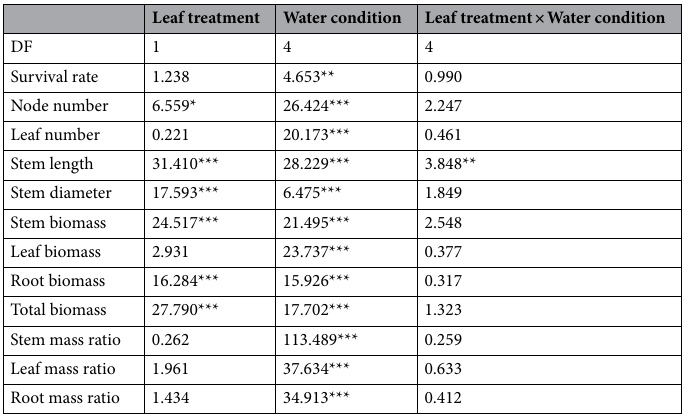
Table 2. Two-way ANOVA for the survival rate, morphological traits, biomass, and biomass allocation of A. philoxeroides in Exp. 2. The degree of freedom (DF), F values and significance levels (*** P < 0.001, ** P < 0.01, * P < 0.05) are